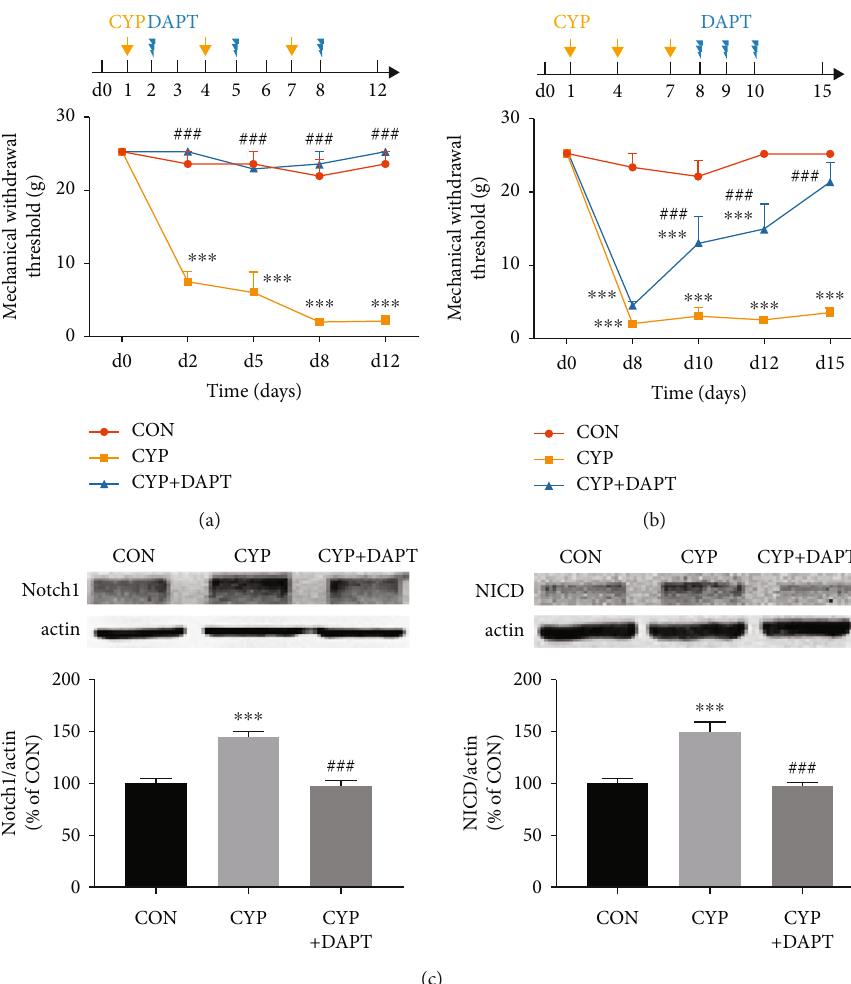
Figure 2: Inhibition of Notch1 signaling attenuated mechanical allodynia in the CYP-induced cystitis model. (a) Intrathecal injection of DAPT (a γ -secretase and Notch1 signaling inhibitor) the day after every CYP injection could reverse the reduced mechanical withdrawal threshold of cystitis animals to the basal level. In comparison, the mechanical withdrawal threshold of the CYP-induced cystitis animals without DAPT treatment persisted at a low level for at least 12 days. n = 8 per group. (b) Intrathecal injection of DAPT after the establishment of the CYP-induced cystitis model for three consecutive days could gradually reverse the decrease of mechanical withdrawal threshold in the cystitis animals. In comparison, the threshold of the cystitis animals without DAPT treatment persisted at a low level for at least 15 days. n = 10 per group. The data in (a) and (b) were analyzed by two-way ANOVA followed by the Tukey post hoc test. (c) The overexpression of Notch1 and NICD in the SDH of cystitis animals in (b) was neutralized by DAPT treatment. n = 4 per group. Data were analyzed by one-way ANOVA followed by the Tukey post hoc test. ∗∗∗ P < 0 : 001 vs. CON group. ### P < 0 : 001 vs. CYP